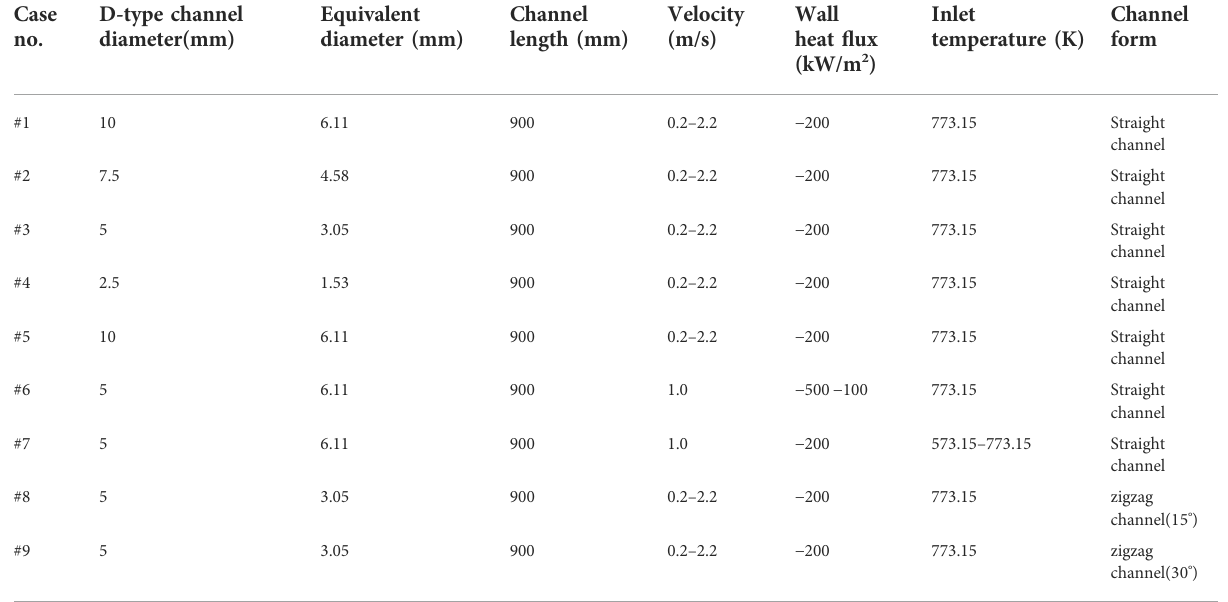
TABLE 1 Numerical simulation working conditions for the D-type channels. Case